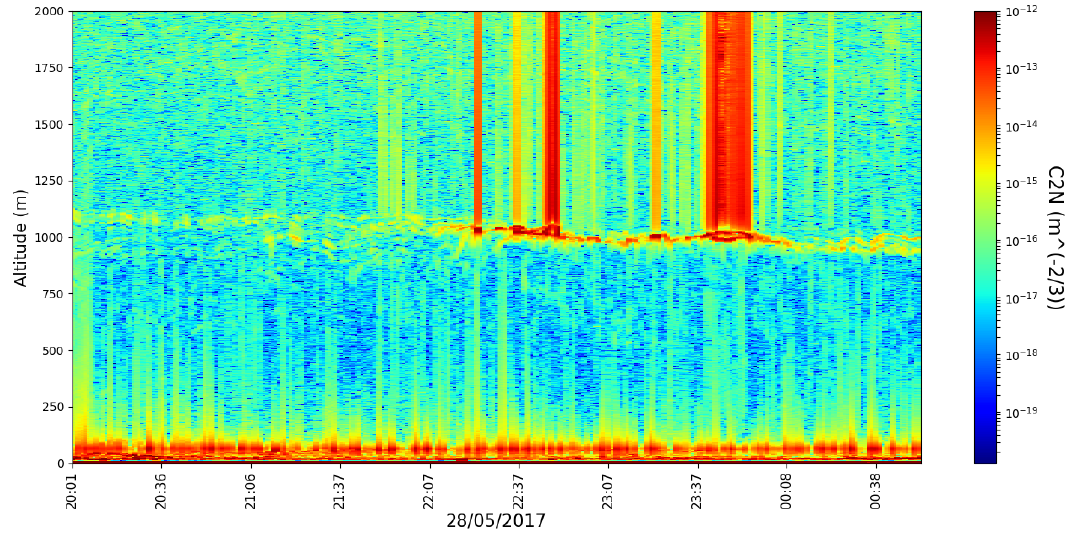
Figure 12. 𝐶 𝑁2 profile timeseries, profiling rate 1/min, 28 April 2017. Figure 12. C 2